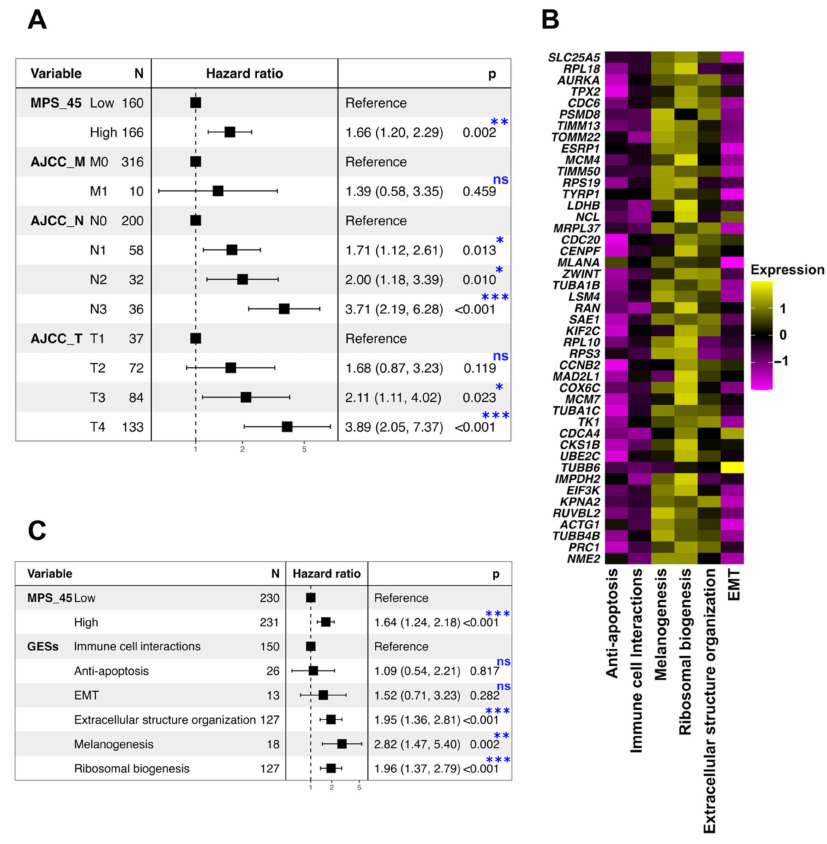
Figure 9. The MPS_45 was potentially associated with prognosis independent of the clinicopathologi- cal characteristics. ( A , C ) Forest plots for multivariate Cox regression analyses for the MPS_45 with ( A ) AJCC staging categories (M, N, and T) and with ( C ) the identified GESs groups. ns (non- significant) and * p <0.05, ** p <0.01, and *** p <0.001. ( B ) Heatmap showing the expression levels of the MPS_45 genes in different TCGA-SKCM GES